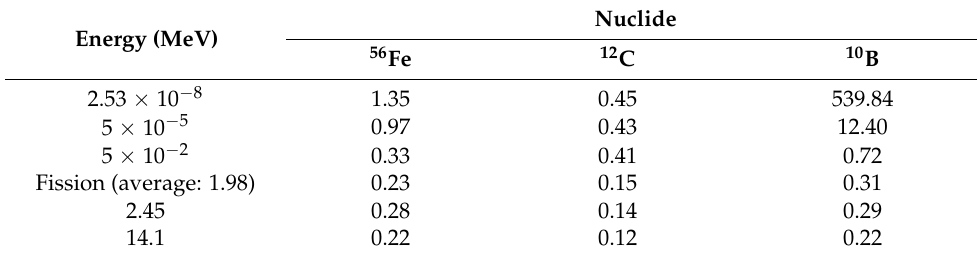
Table 2. Neutron macroscopic cross section (cm − 1 ) of the main